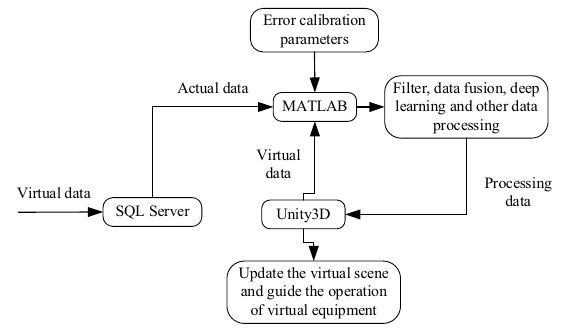
Fig. 2 System software